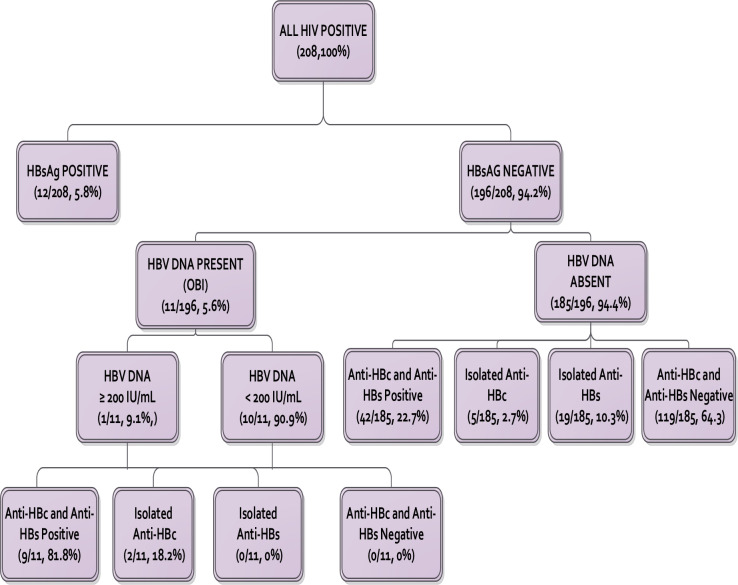
HBV serological and DNA markers.